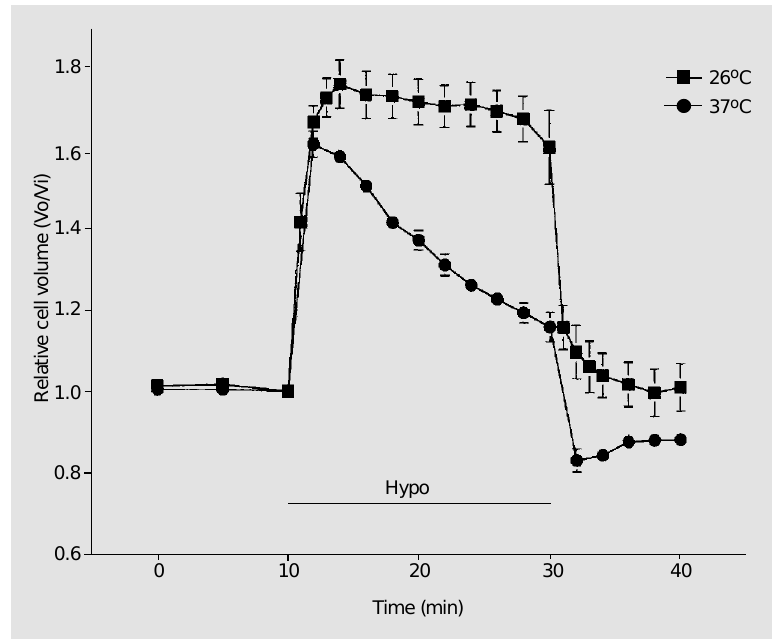
Figure 1 - Cultured chick embryo cardiomyocytes cannot activate volume regulatory pro- cesses at room temperature. The cells were exposed to a 180 mOsm/kg H 2 O hyposmotic stimulus (hypo) at 37 o C (circles) and 26 o C (squares). At 26 o C the myocytes cannot recover to near control volumes as compared to the myocytes at 37 o C. Data are reported as means ± SEM, N = 14 for 37 o C and N = 9 for 26 o C. Vo: Observed volume; Vi: initial